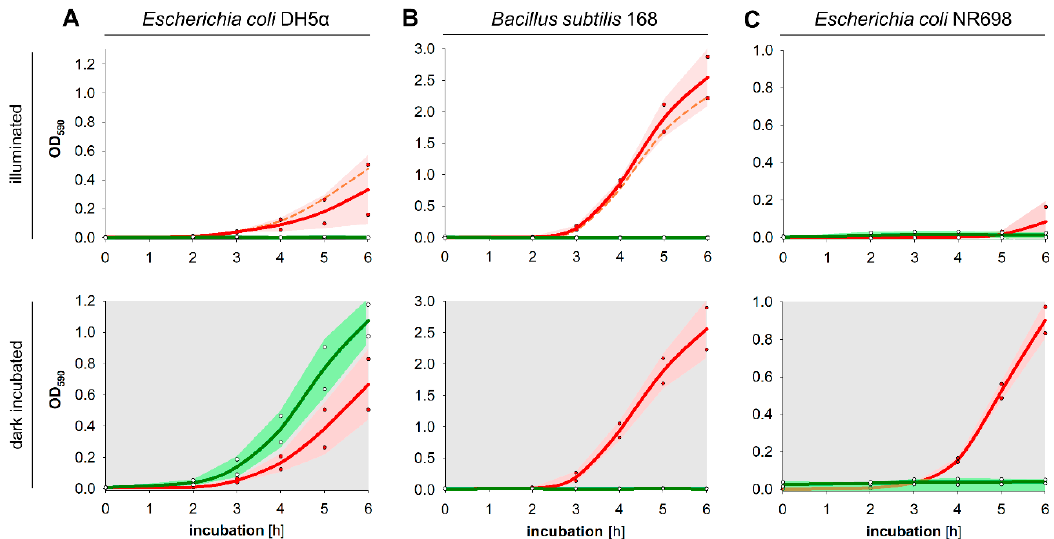
Figure 3. Effect of chlorophyllin on the early growth phase of (A) Escherichia coli DH5 α , (B) Bacillus subtilis 168, and (C) Escherichia coli NR698. Liquid cultures of bacteria (initial cell number: 10 6 cfu/mL) were incubated in Erlenmeyer flasks in standard LB medium (red) and in presence of a chlorophyllin concentration of 22 mg/L (green). Cells grew either illuminated with 12 mW/cm 2 (bright plots, upper row) or in darkness (grey plots, lower row). Depicted are measured values (circles) and fitted curves (solid lines) with corresponding 95% confidence limits (red and green areas). Dashed lines describe growth of example cultures in LB medium + MeOH/KOH (solvent of chlorophyllin).